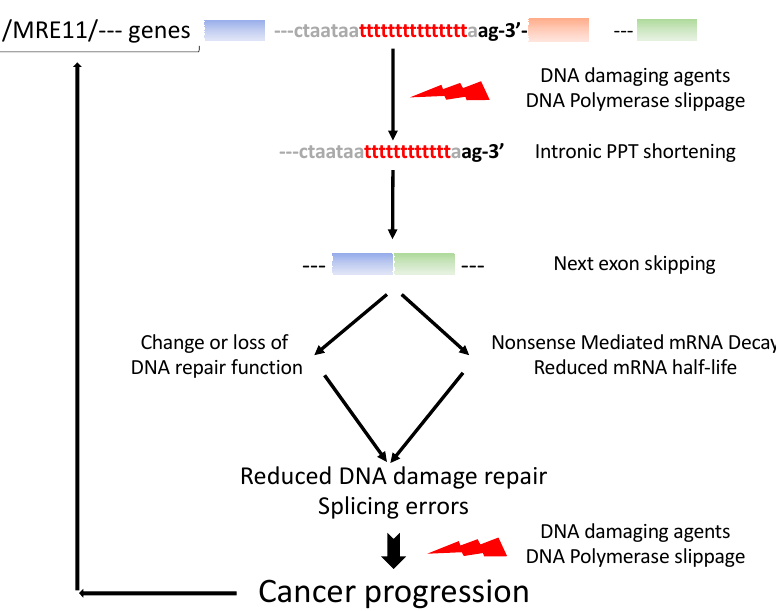
Figure 3. Model of incidence of pre-mRNA splicing errors in MSI cancer progression. DNA damage and replication errors trigger exon skipping in genes with intronic PPT shortening. The corresponding pre-mRNA structures are changed such that the function of the gene may be changed or the mRNA be targeted to the NMD surveillance system and degraded. The same errors may then be produced over again over the course of the cancer progression.